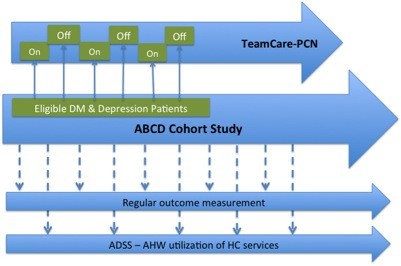
Schematic of Overall Design for TeamCare-PCN Study.